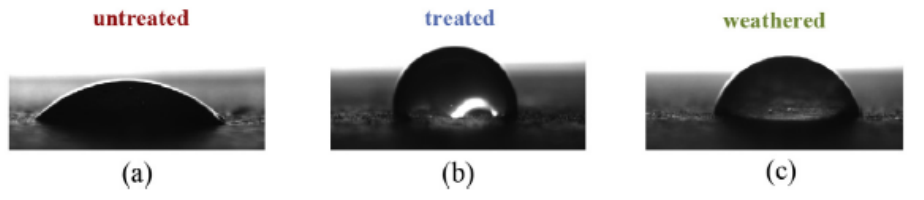
Figure 17. Study on contact angle (CA) for ( a ) untreated, ( b ) treated, and ( c ) weathered specimens [90].